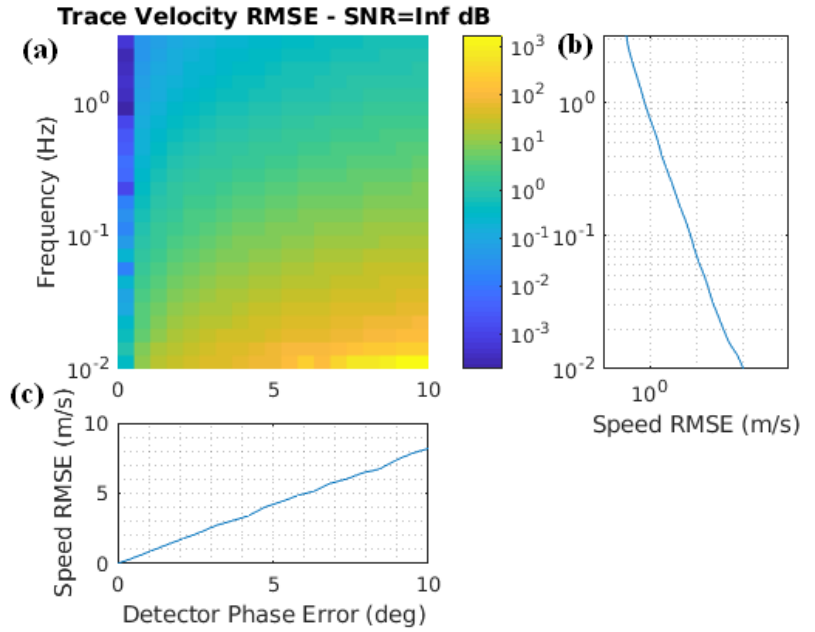
Figure 20. The same as Figure 19 but for trace velocity. ( a ) RMSE for a case with no noise, and a consistency threshold of 0.1 s, as a function of frequency and sensor phase error, ( b ) median RMSE over all sensor phase errors, ( c ) median RMSE over all